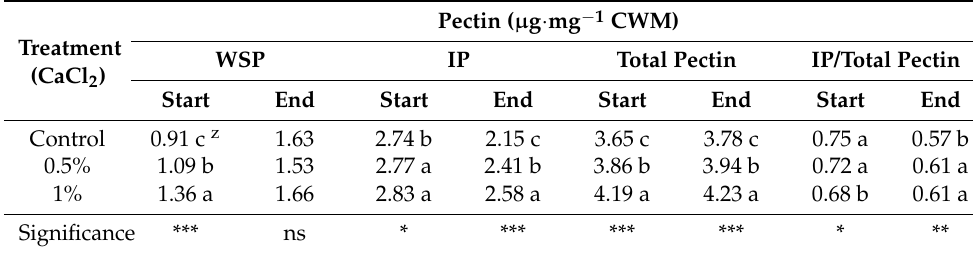
columns by LSD at p = 0.05 ( n = 30). ns, non-significant; *, ** , *** mean significant at p < 0.05 or 0.01 or 0.001, respectively, ANOVA.